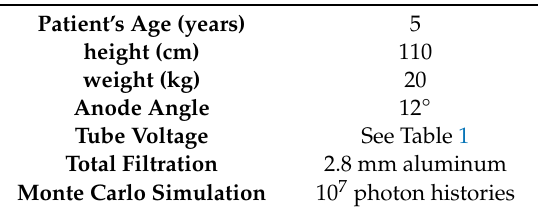
Table 2. The parameters used in the PC-based Monte Carlo program for calculating patient doses in medical X-ray examinations (Monte Carlo